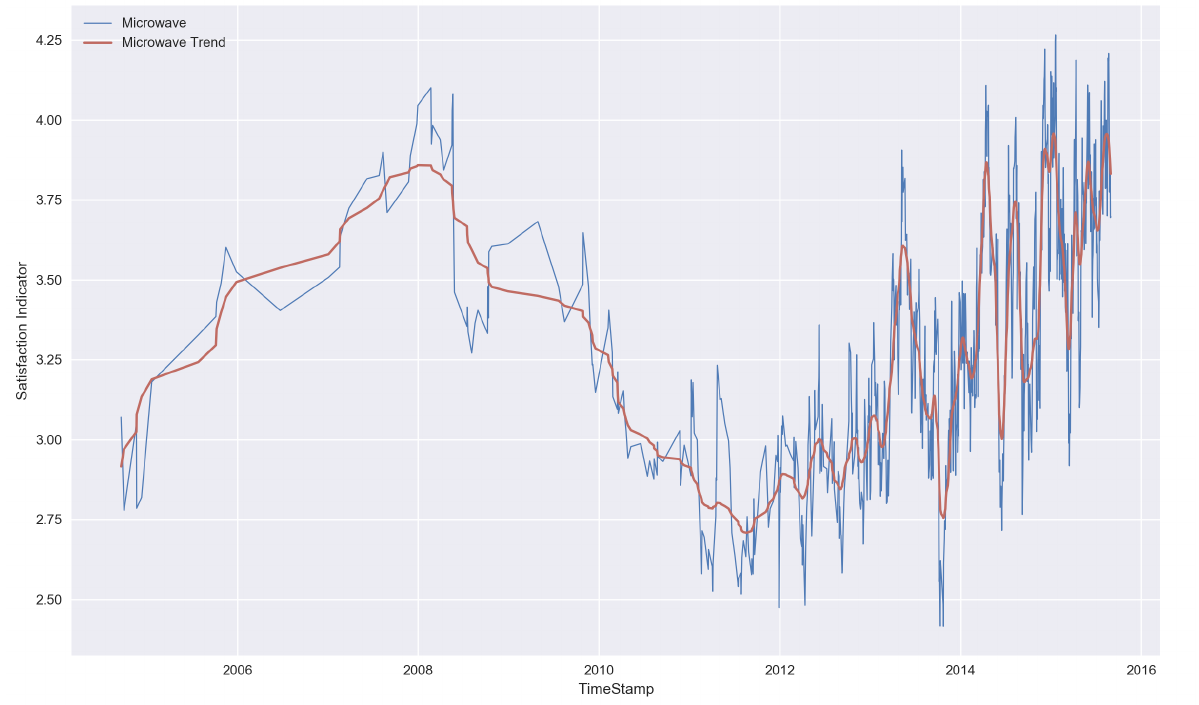
Figure 3. Weighted satisfaction curve of the microwave